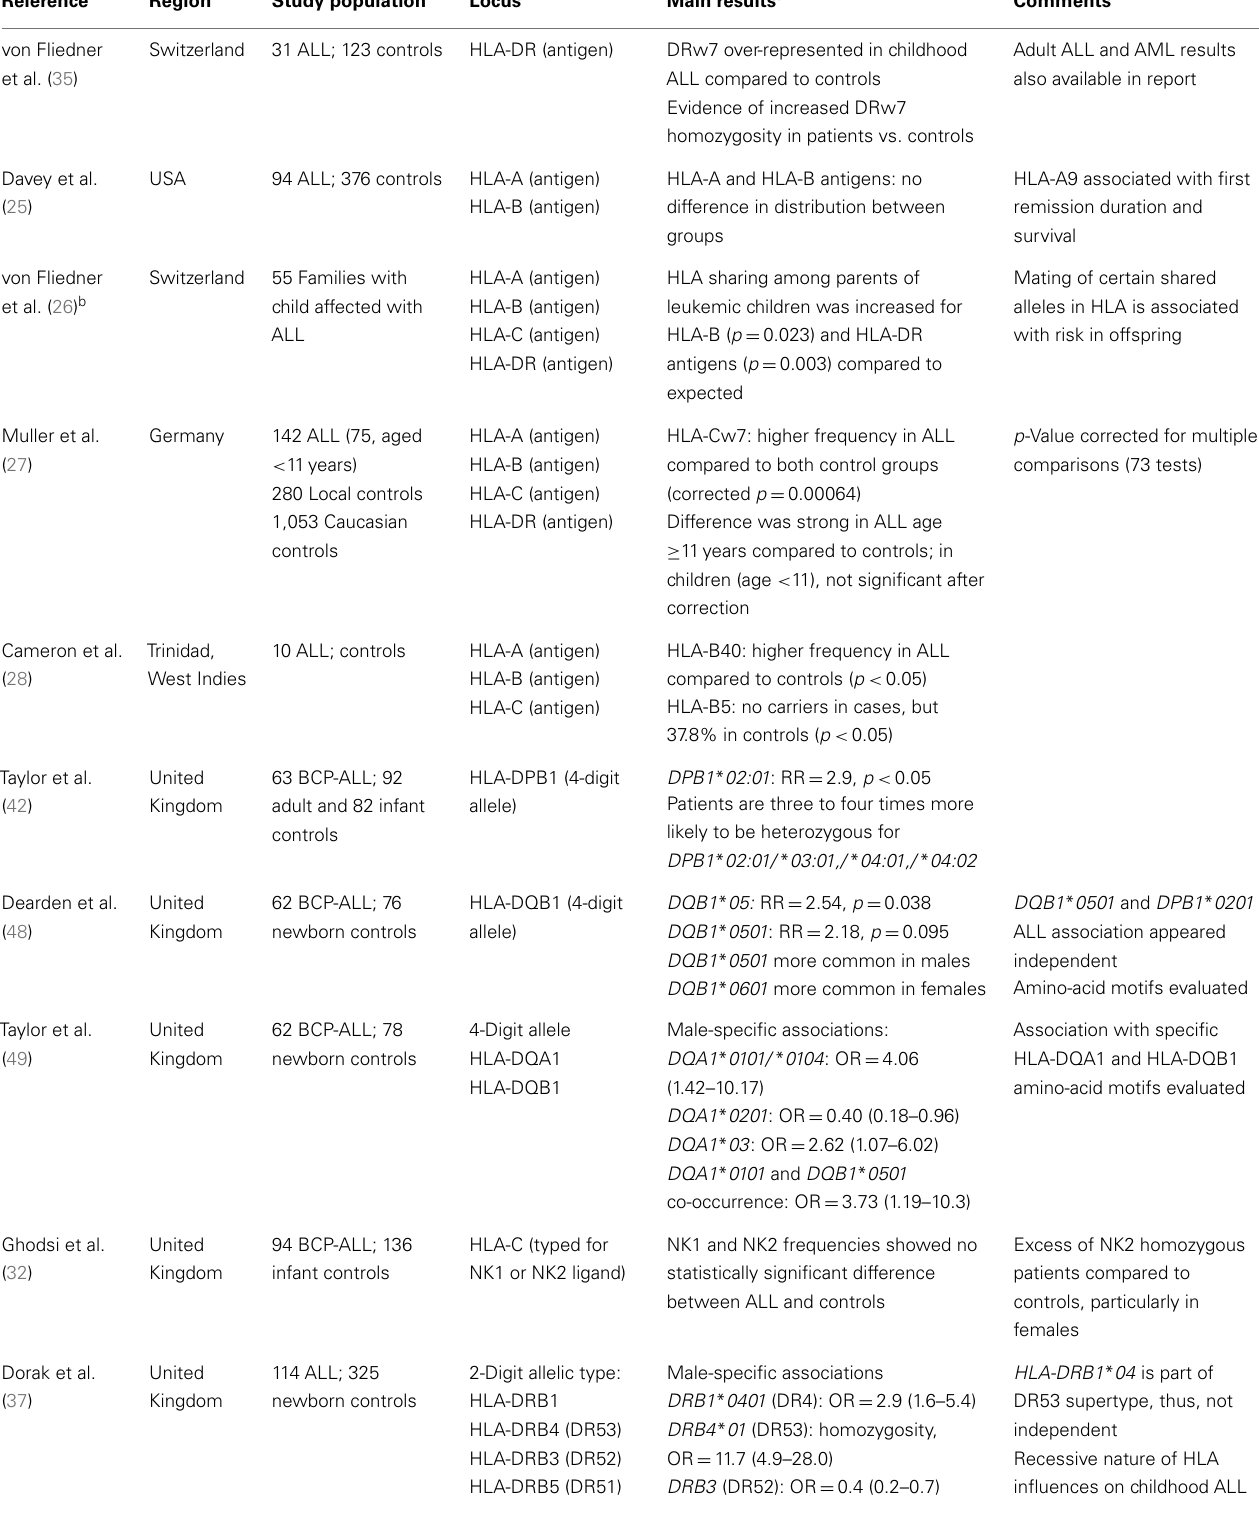
Table 1 | Studies evaluating the association between HLA genetic variation andALL risk specifically in children